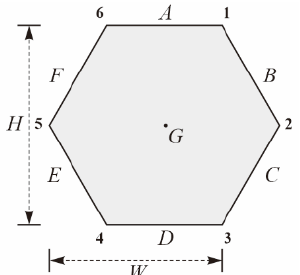
Figure 5. Schematic diagram of the attribute of a regular hexagon ( W :